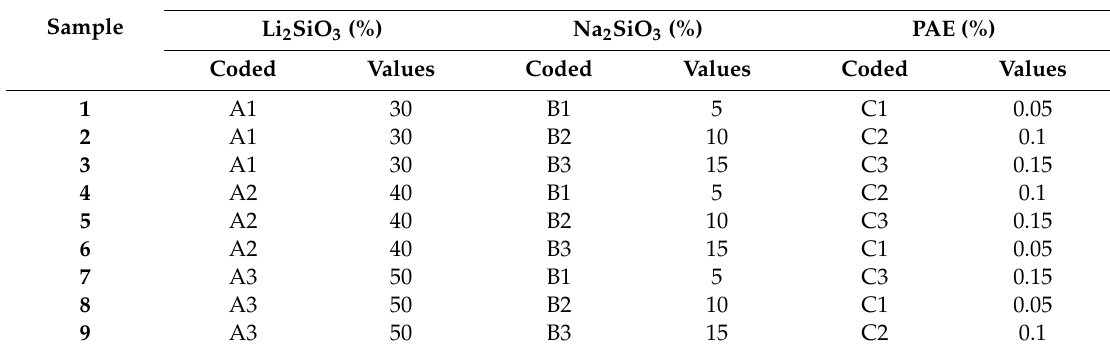
Table 2. Absolute values of the variables (Li 2 SiO 3 , Na 2 SiO 3, and PAE) and the orthogonal array for L 9